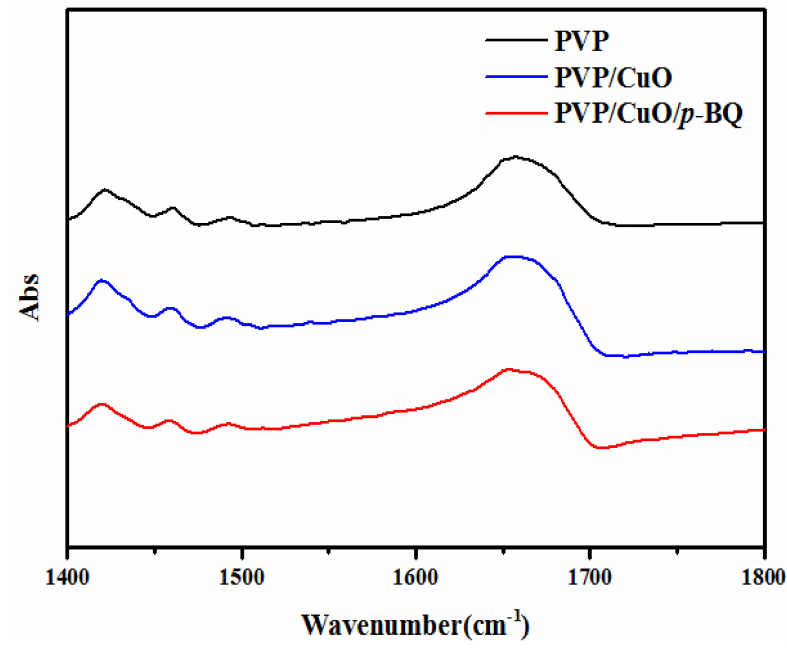
Figure 2. IR spectra of PVP, PVP/CuO, and PVP/CuO/ p -BQ composites.